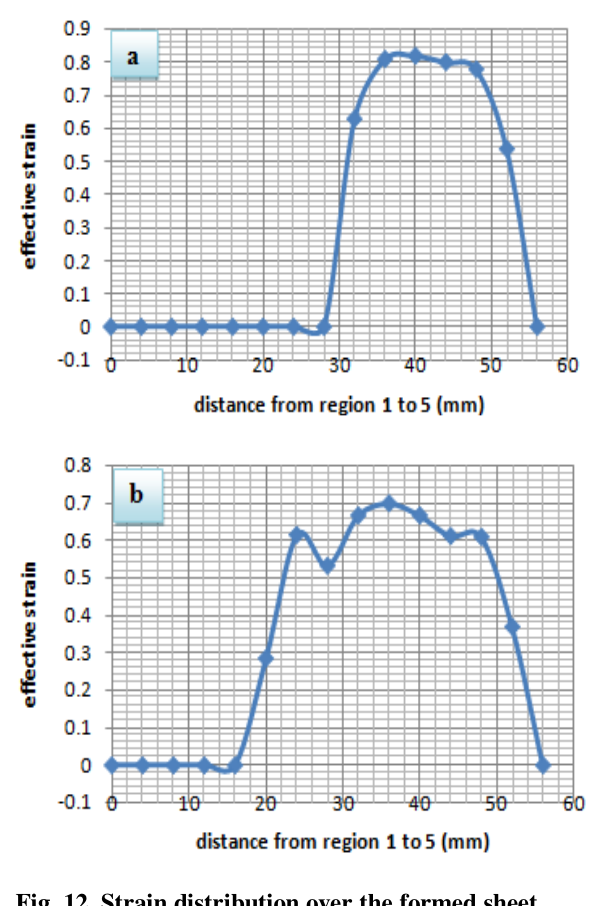
Fig. 12. Strain distribution over the formed sheet for experiment (3), a) 55 ◦ , b) 45 ◦ . .